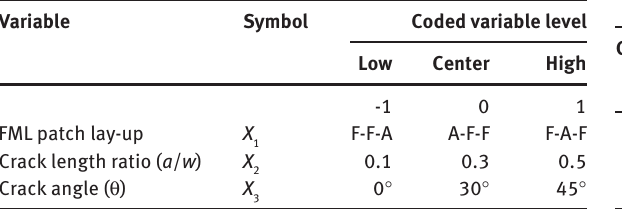
Table 4 The level of variables chosen for the response surface design.